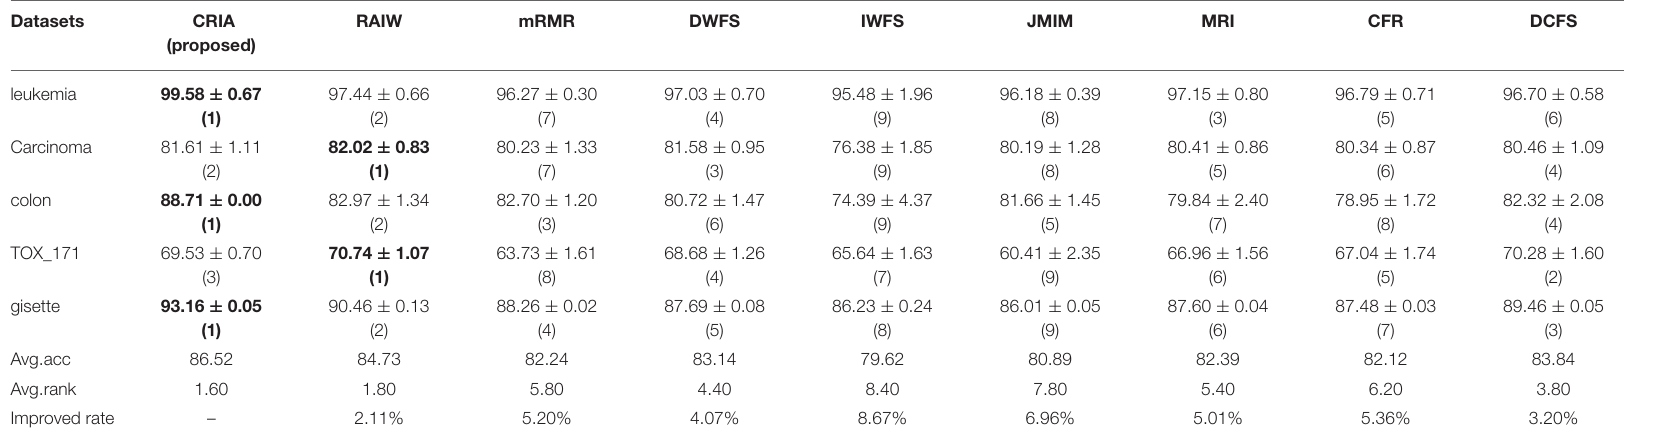
TABLE 5 | Comparision (mean ± std.dev.) of performance between CRIA and other 8 algorithms with Naïve Bayes classifier.